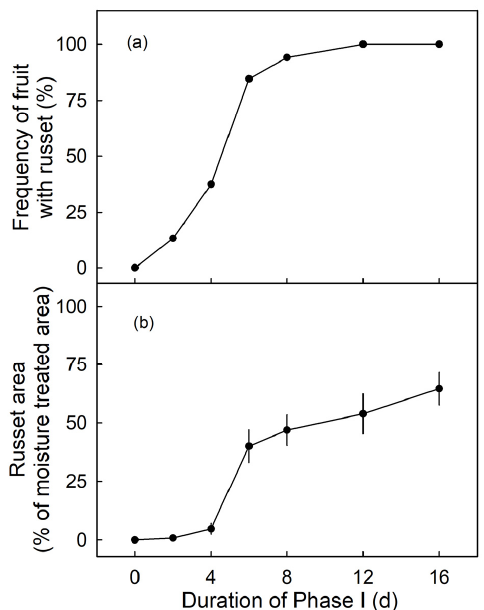
Figure 5. Effect of duration of moisture exposure (Phase I) on the frequency of russeted fruit ( a ) and the percentage of the moisture-exposed area that is russeted at maturity (156 days after full bloom; DAFB) ( b ). Fruits were exposed to moisture starting from 31 DAFB for 0, 2, 4, 6, 8, 12 or 16 d. Data represent means ± SE ( n = 9–31). Plants 2020 , 9 , x FOR PEER REVIEW